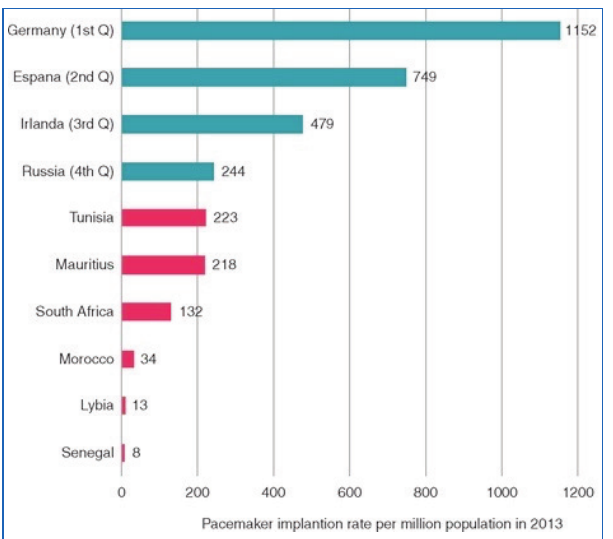
Figure 1: Implantation rate estimated to be 138.25/million in 2016 (total population 54146735, total number 7485) US rates are double Germany